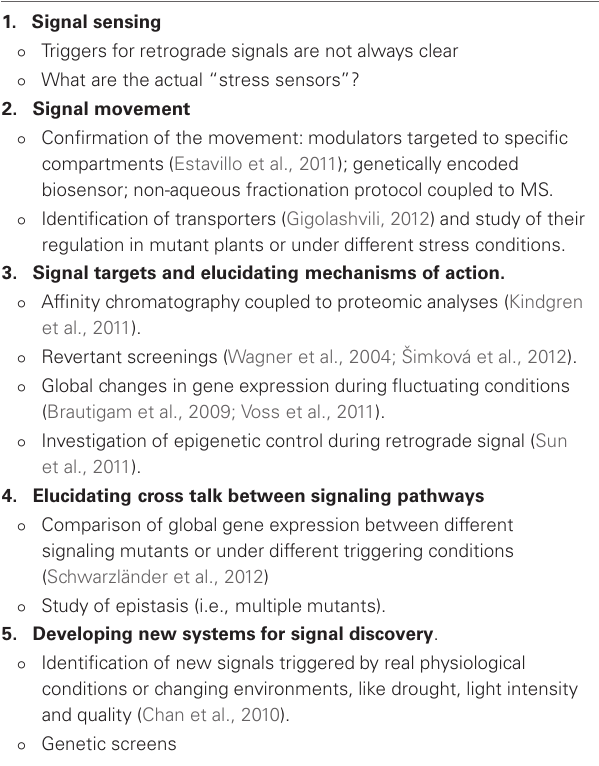
Table 1 | Investigation of retrograde signaling